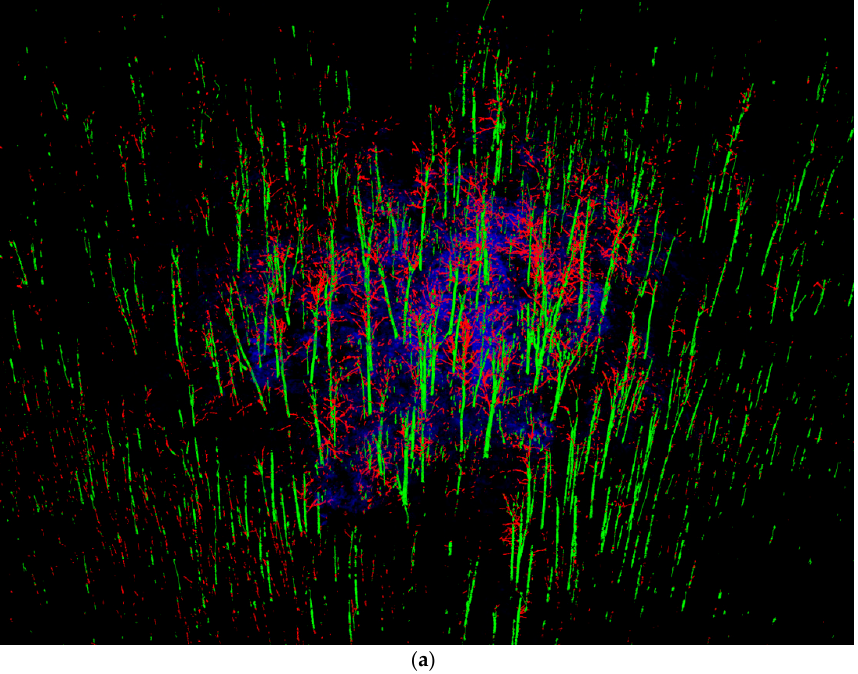
( b ) Figure 11. Example wood reconstruction from a maple plot (1 ha): ( a ) a 3-D FCN filtered plot scan, with stem in green, branch in red, and other points in blue; ( b ) QSM reconstructed wood curves, with stem in green, branch in red, understory in cyan, and isolated wood in yellow. To balance the level of graphic details, blue points in ( a ) are assigned with transparency degree of 0.99, and stem curves are set four times thicker than all other curves. 5. Conclusions Delineating wood components in complex natural forest environments has attained wide research interest, represented by QSM development, due to its importance to modern wood management in pursuit of correct and complete biomass, carbon budget, and tree physiology. At the